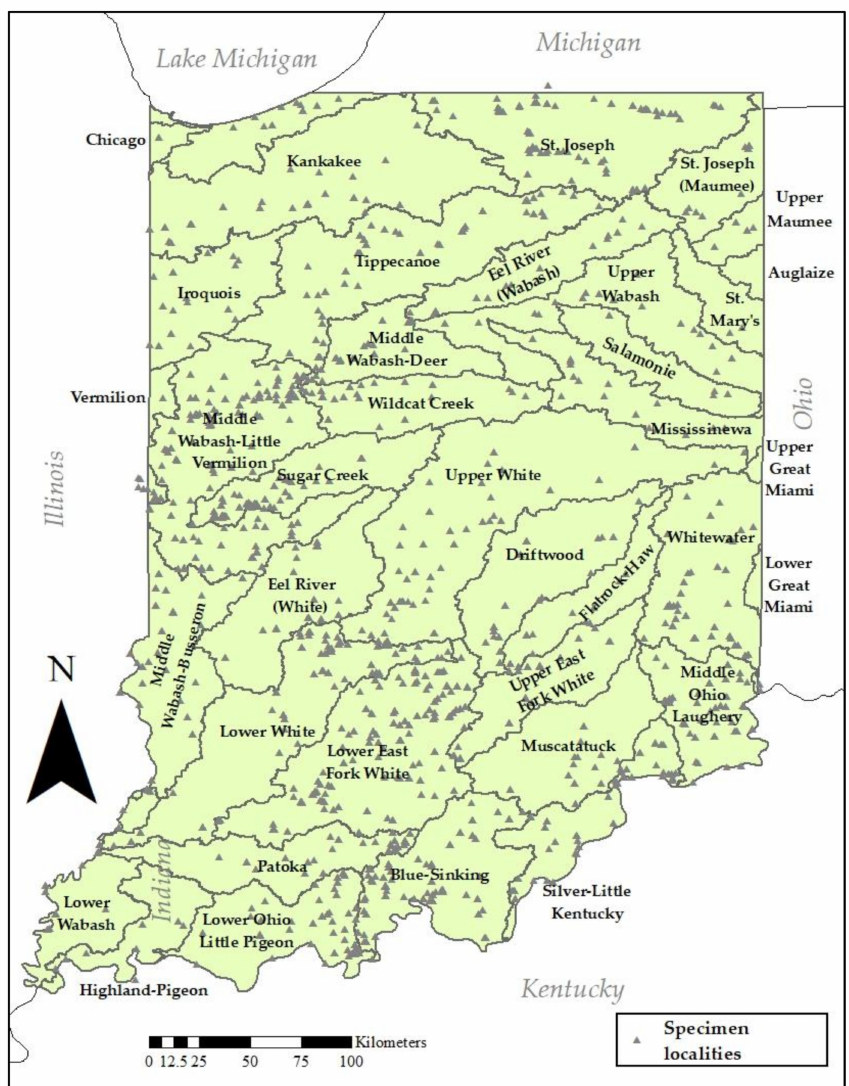
Figure 2. Map of Plecoptera specimen localities in